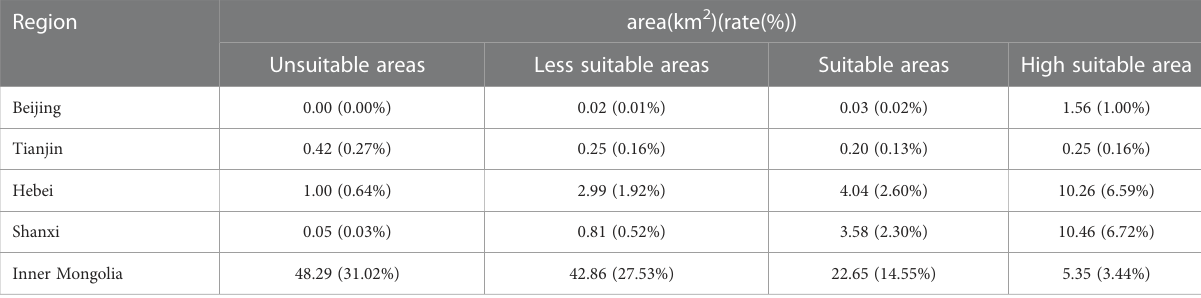
TABLE 3 The proportion of suitable areas for growing different grades of naked oat in North China.